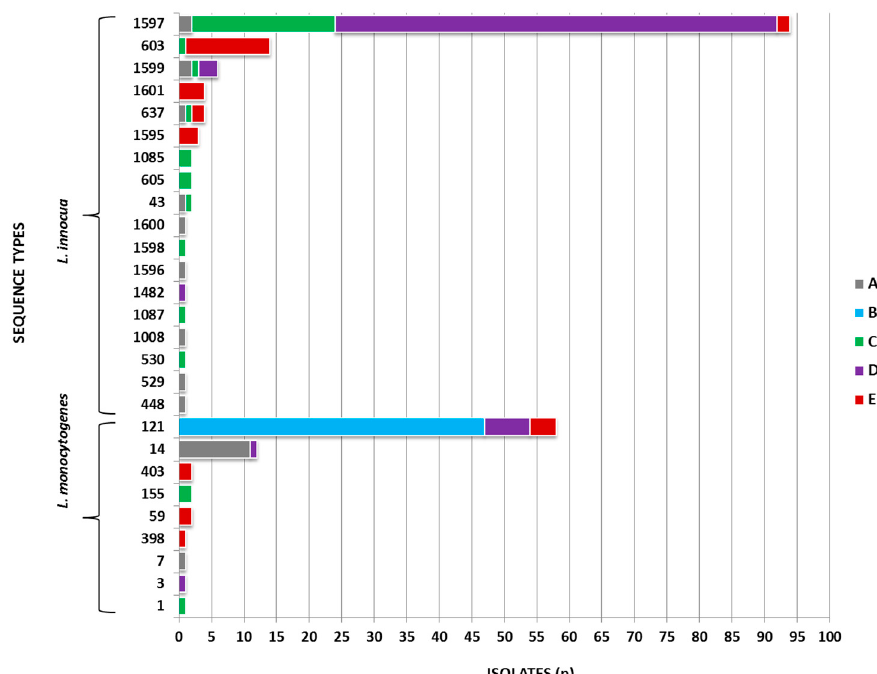
Figure 2. Comparison of the L. innocua and L. monocytogenes ST s identified in this study to the Institute Pasteur MLST isolate database (https://bigsdb.pasteur.fr/listeria/listeria.html) was performed to identify highly abundant housekeeping genes, CC and STs (Table S1). Interestingly, some housekeeping genes were not specific for L. monocytogenes genetic lineage III or L. innocua .